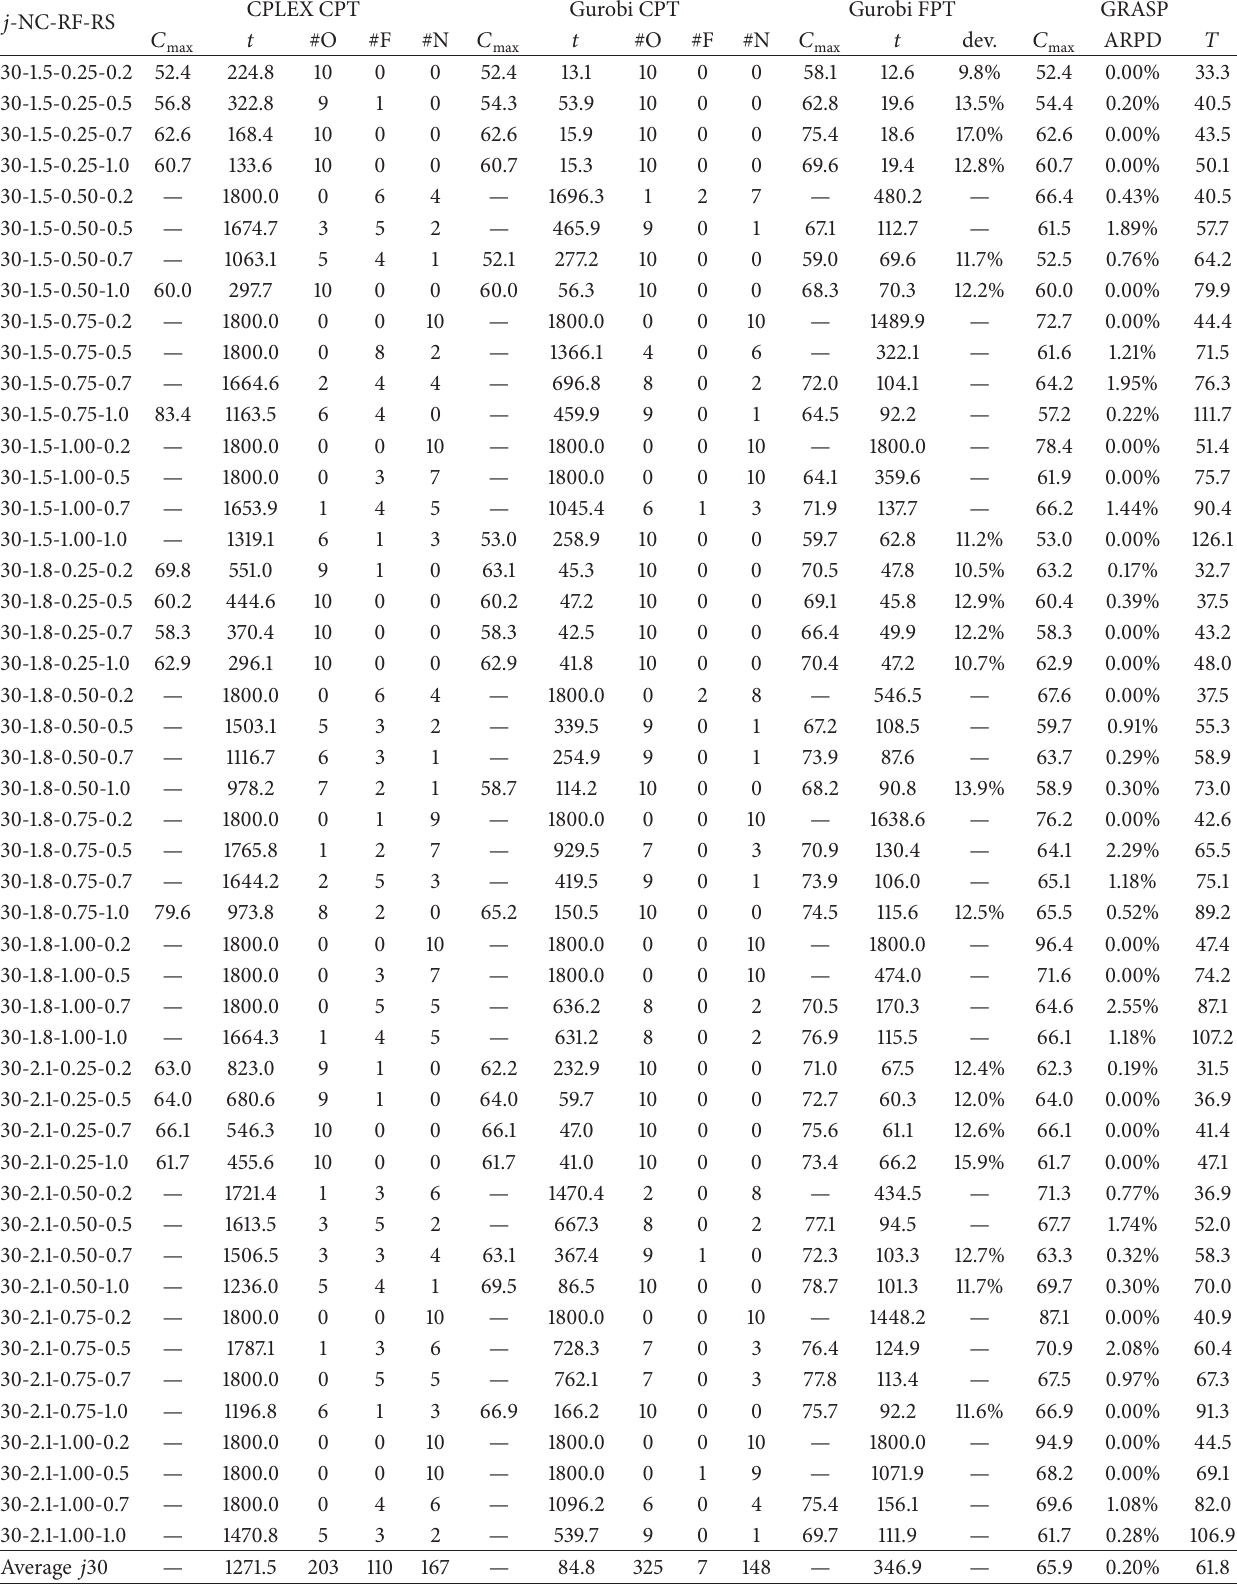
Table 6: Experimental results for 30